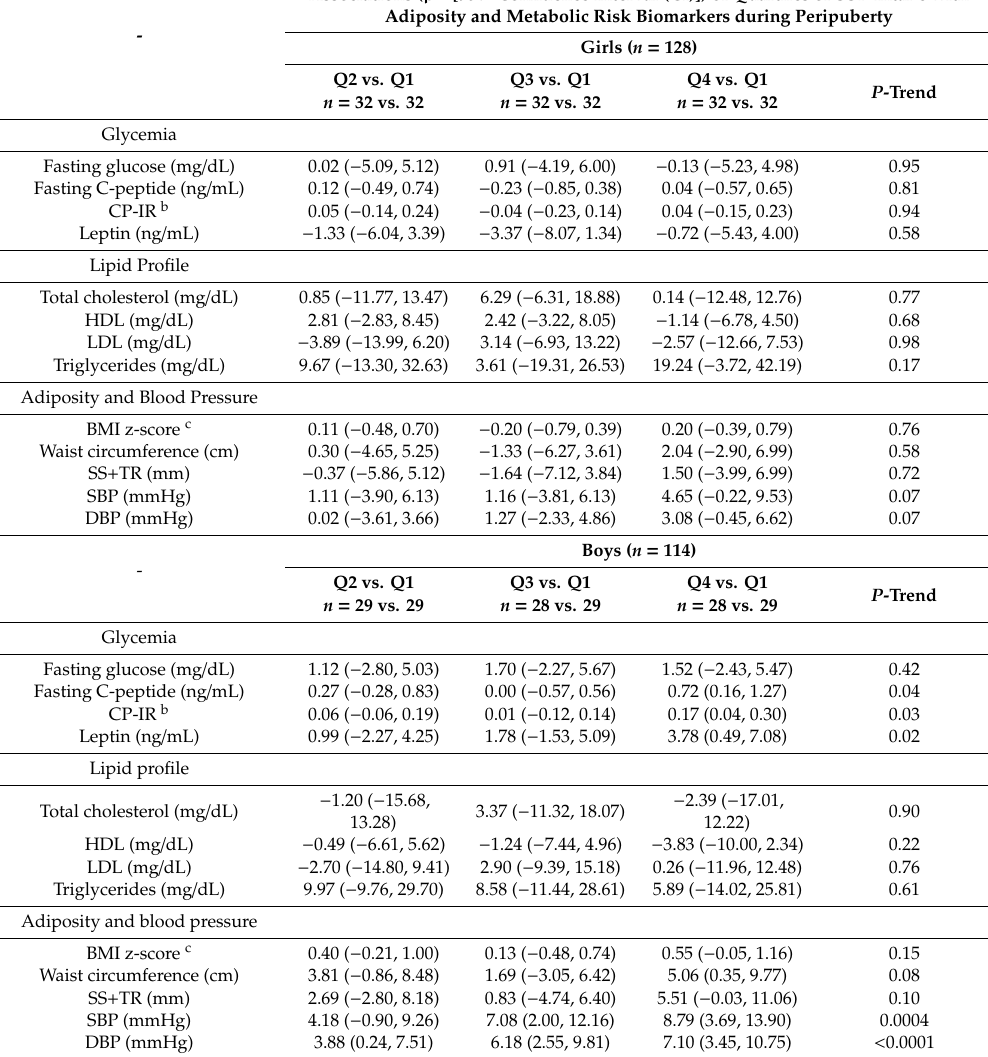
Table 2. Associations of quartiles of sugar-sweetened beverage (SSB) intake with metabolic biomarkers in ELEMENT participants during